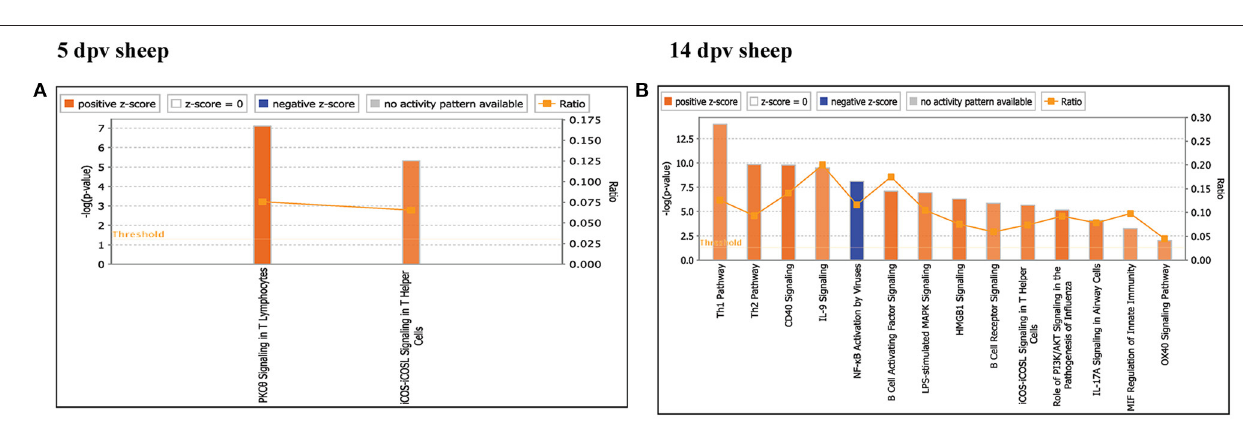
FIGURE 4 | Canonical pathways activated/inactivated in vaccinated sheep (A) 5 days post-vaccination (dpv) and (B) 14 dpv were generated in core analysis of the Ingenuity Pathway Analysis (IPA) tool. Red pathways are activated ( > 2), and blue pathways are inactivated ( < 2). Height of the bar graphs indicates -log ( p -value), and the line graph shows the ratio of listed proteins found in each pathway over the total number of proteins in that pathway. The uniport ID of differentially expressed proteins (DEPs) was converted into gene ID, and this list of proteins with corresponding fold change was uploaded in IPA for downstream